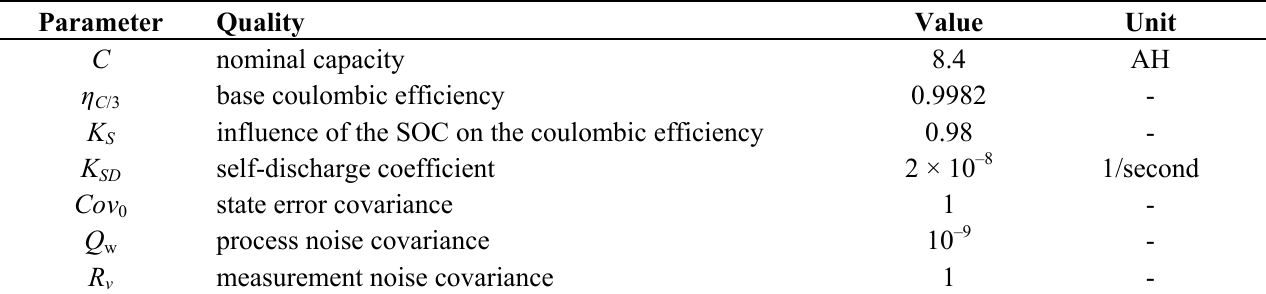
Table 4. Initial values of SOC